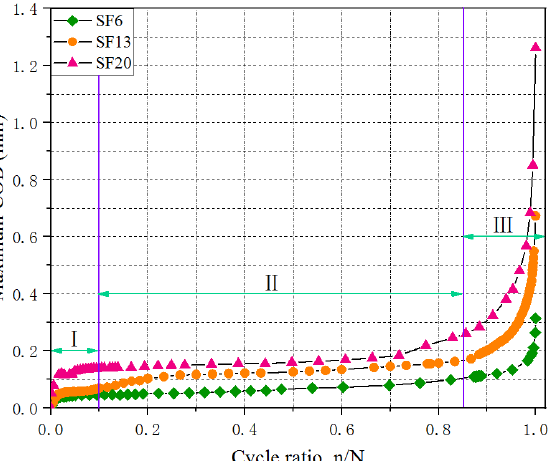
Figure 6. Evolution of maximum COD with the cycle ratio for UHPC with different fiber lengths.